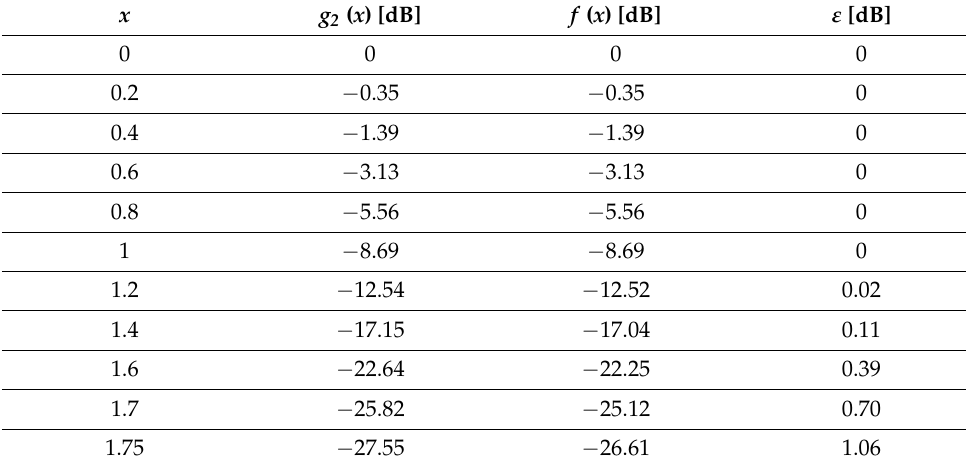
Table 1. Comparison between g 2 ( x ) and f ( x ) functions.